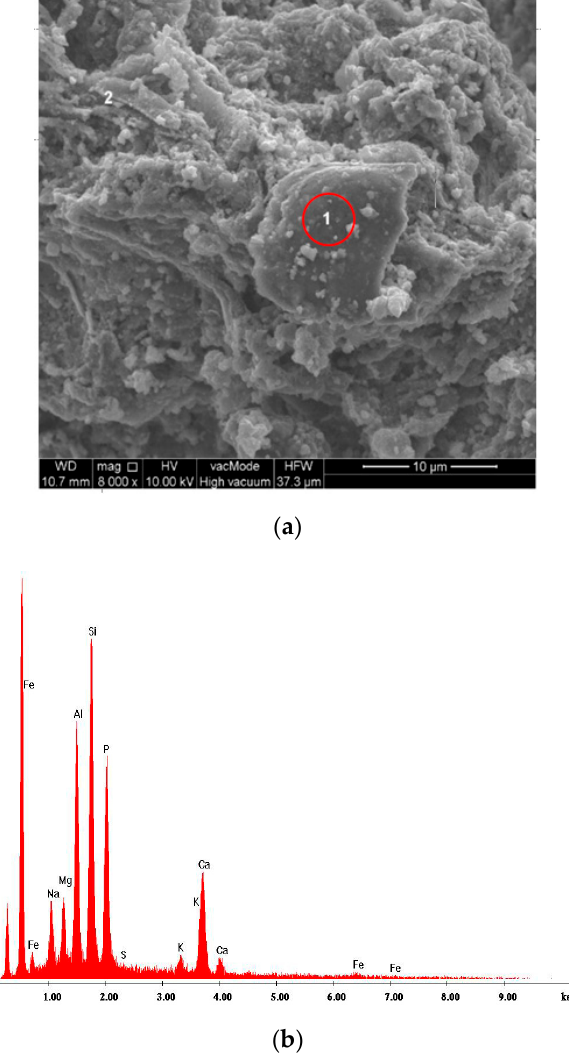
Figure 4. SEM images ( a ) of the tested fly ashes with EDS analysis of the point marked as “1” ( b ).